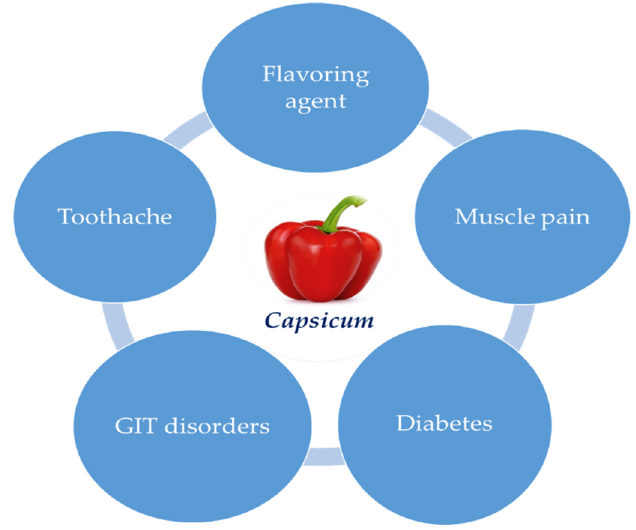
Figure 1. Traditional uses of Capsicum